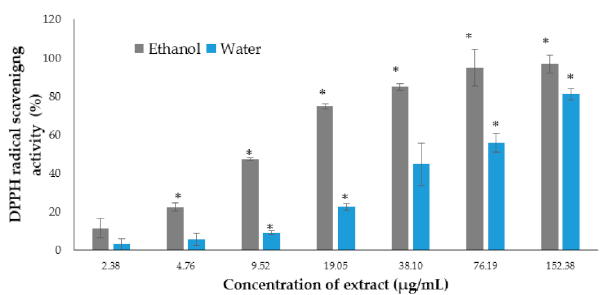
Figure 1. DPPH radical scavenging activity of the ethanol and water extracts of P. australis. Data are expressed as the mean ± SD ( n > 3). * p < 0.05 represents significant differences from the negative control.